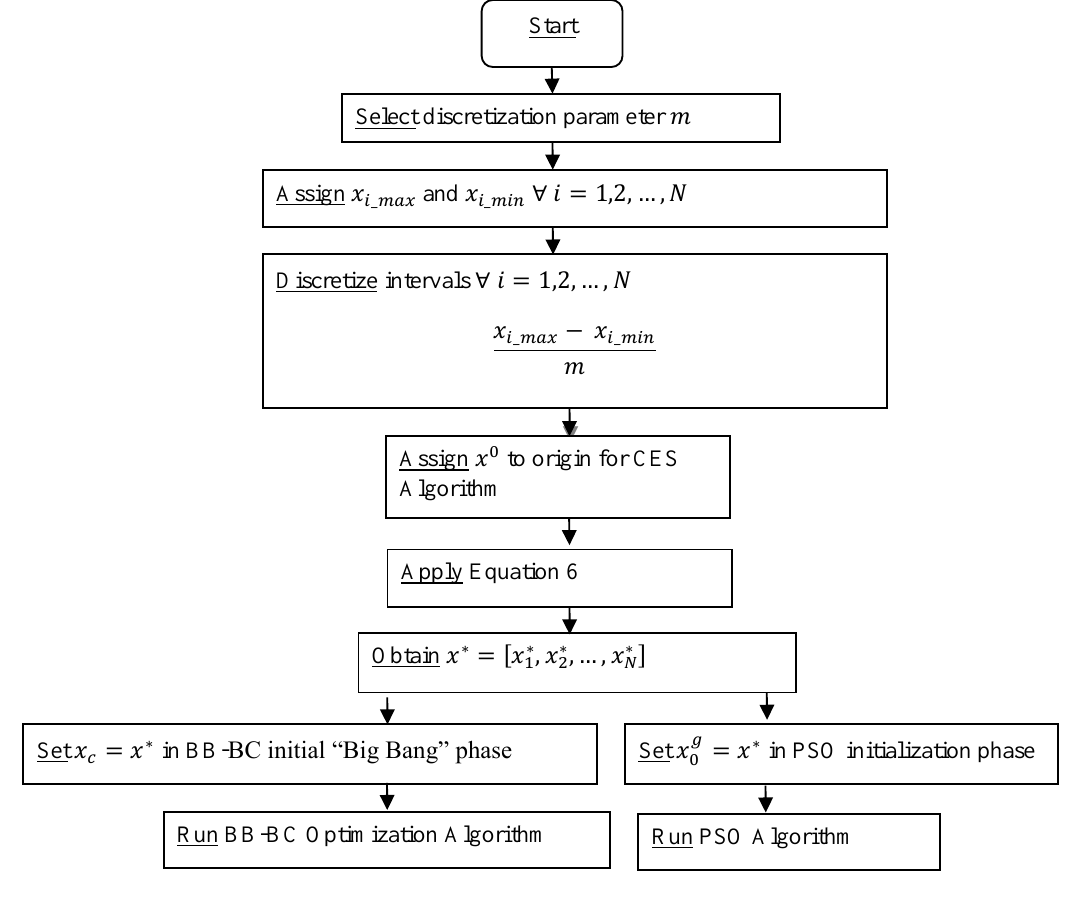
Figure 2. The flowchart of CES-BB-BC optimization and CES-PSO algorithms.